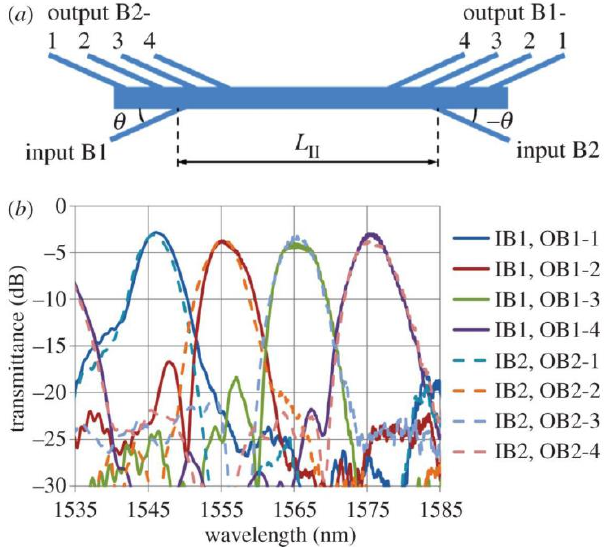
Figure 3. Bidirectional angled multimode interferometer (MMI) showing the ( a ) top-view device schematic and ( b ) measured device performance (reprinted from [52], Royal Society, 2015).